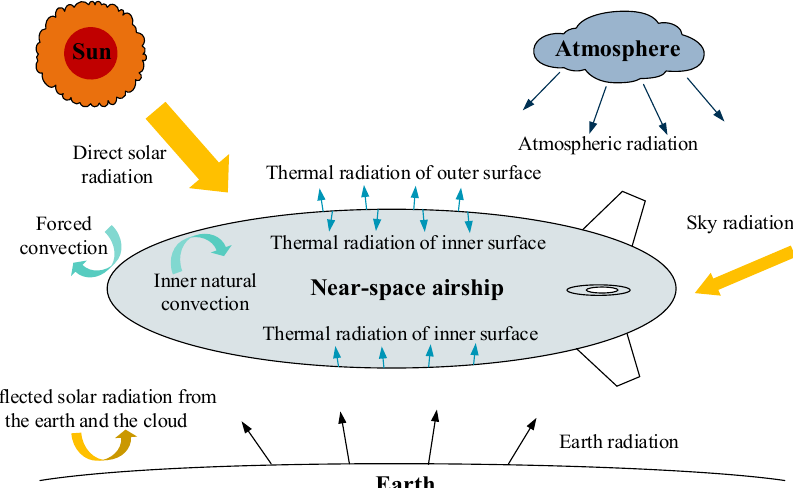
Figure 2. Near-space airship thermal environment.